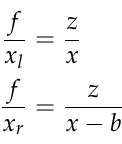
Figure 3. Camera model comparison between the stereo camera and the RGB-D camera. ( a ) A standard stereo camera. The subscripts r denotes the right camera, and l denotes the left one; ( b ) an RGB-D camera. There is another virtual reference plane beyond the object